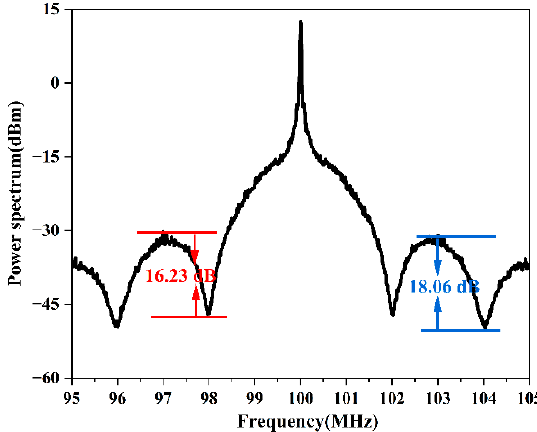
Figure 5. Plot of the experimentally obtained PSD using a 100 m long delay fiber.